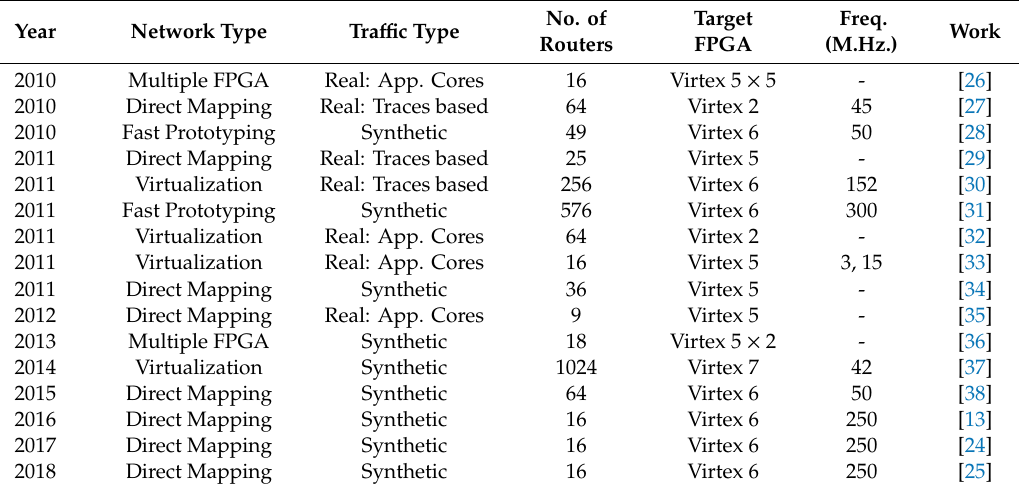
Table 2. NoC Evaluation Tools based on FPGA(s)